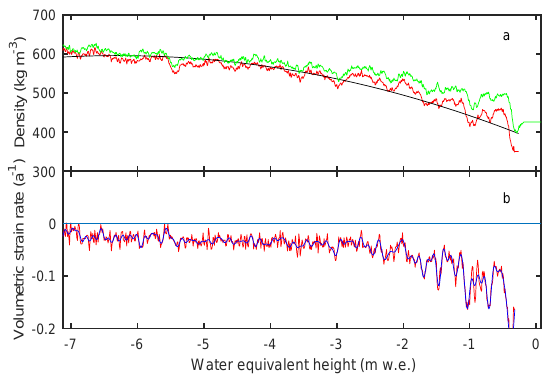
Figure 3. Density and volumetric strain-rate profiles from Site 21 along the iSTAR traverse. ( a ) Density profiles from the austral summers of 2013/14 (red curve) and 2014/15 (green curve), and a fitted polynomial curve showing ρ 0 for 2013/14. ( b ) Volumetric strain rate at intervals of 1 cm w.e. (red curve) and smoothed over ≈ 3 cm w.e. (blue curve).